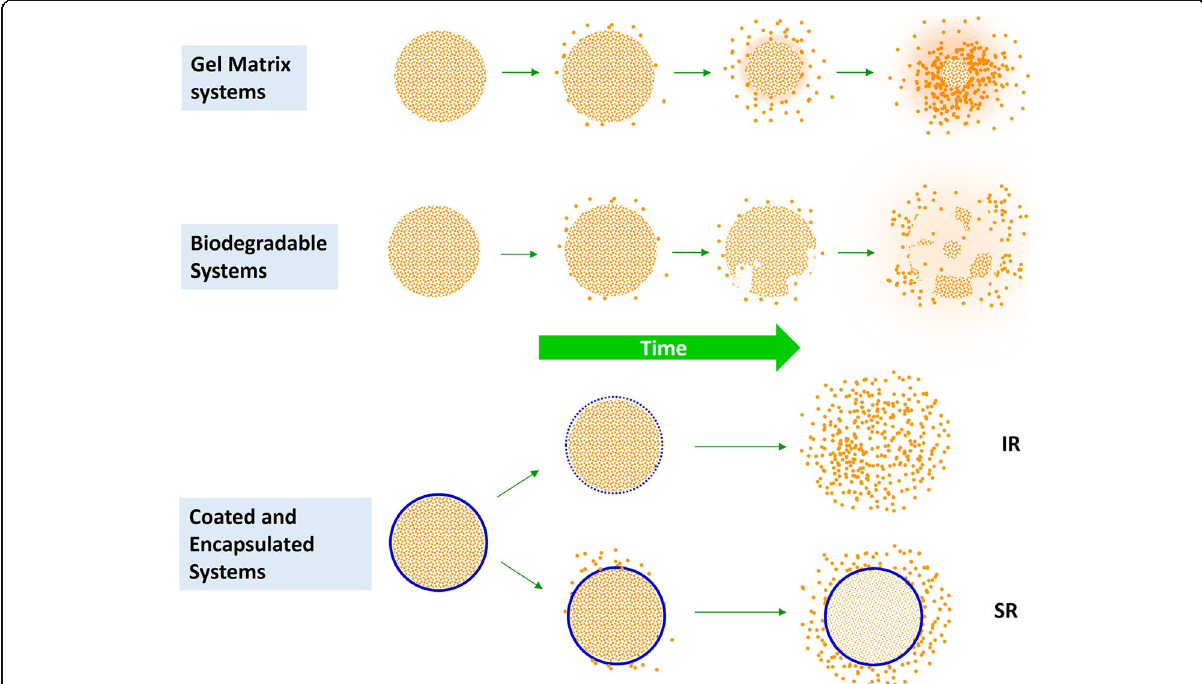
Fig. 1 Mechanism of drug release from the polymer-based drug delivery systems discussed in this paper. IR, immediate release; SR, sustained release. Spheres represent drug molecules. In the matrix and biodegradable systems shown, the polymer is uniformly distributed with the drug. Drug release occurs by diffusion through the matrix and gel erosion (e.g., hypromellose-based tablets) or biodegradation (e.g., poly(lactide-co- glycolide)-based systems). In coated or encapsulated systems, a polymer forms a film or shell around drug particles. In coated IR systems, the film dissolves rapidly, while in coated SR systems, drug release occurs gradually by diffusion through an insoluble polymer